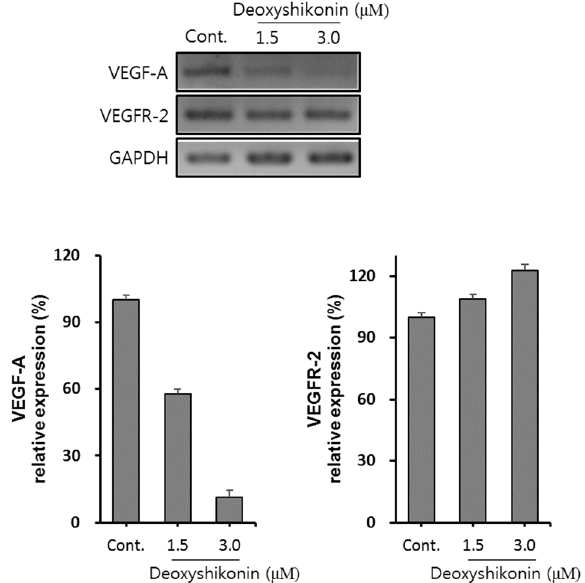
Figure 4. Effect of deoxyshikonin on vascular endothelial growth factor (VEGF-A) and vascular endothelial growth factor receptor (VEGFR)-2 mRNA expressions in HUVECs. HUVECs were seeded into 6-well plates (3 × 10 5 cells/well), then treated with deoxyshikonin as indicated concentration for 24 h. Total RNA was extracted from deoxyshikonin-treated HUVECs, and human VEGF-A mRNA or human VEGFR-2 mRNA expression were analyzed by RT-PCR. Glyceraldehyde-3-phosphate dehydrogenas (GAPDH) was used as an internal control. Data are expressed as means ± SEM. Similar results were obtained from three independent experiments.